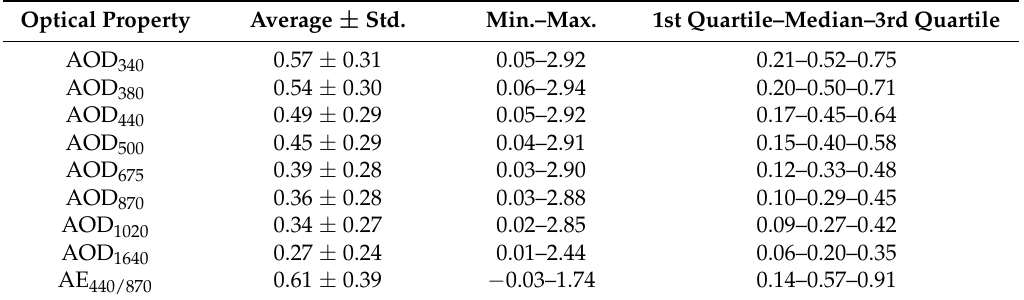
Figure 2. Frequency distributions of mean daily: ( a ) AOD 500 and ( b ) AE exponent, measured over Kuwait for the time period 2008–2017. Red cross mark and the red vertical line refers to the statistical mean and to the median value of the distribution, respectively. Blue box corresponds to the 1st and 3rd quartiles and black whiskers are bounds for the 9% and 91%. Table 1. Basic statistics on the daily AOD values (at various wavelengths) and Ångström coefficient (AE) over Kuwait, for the period 2008–2017.